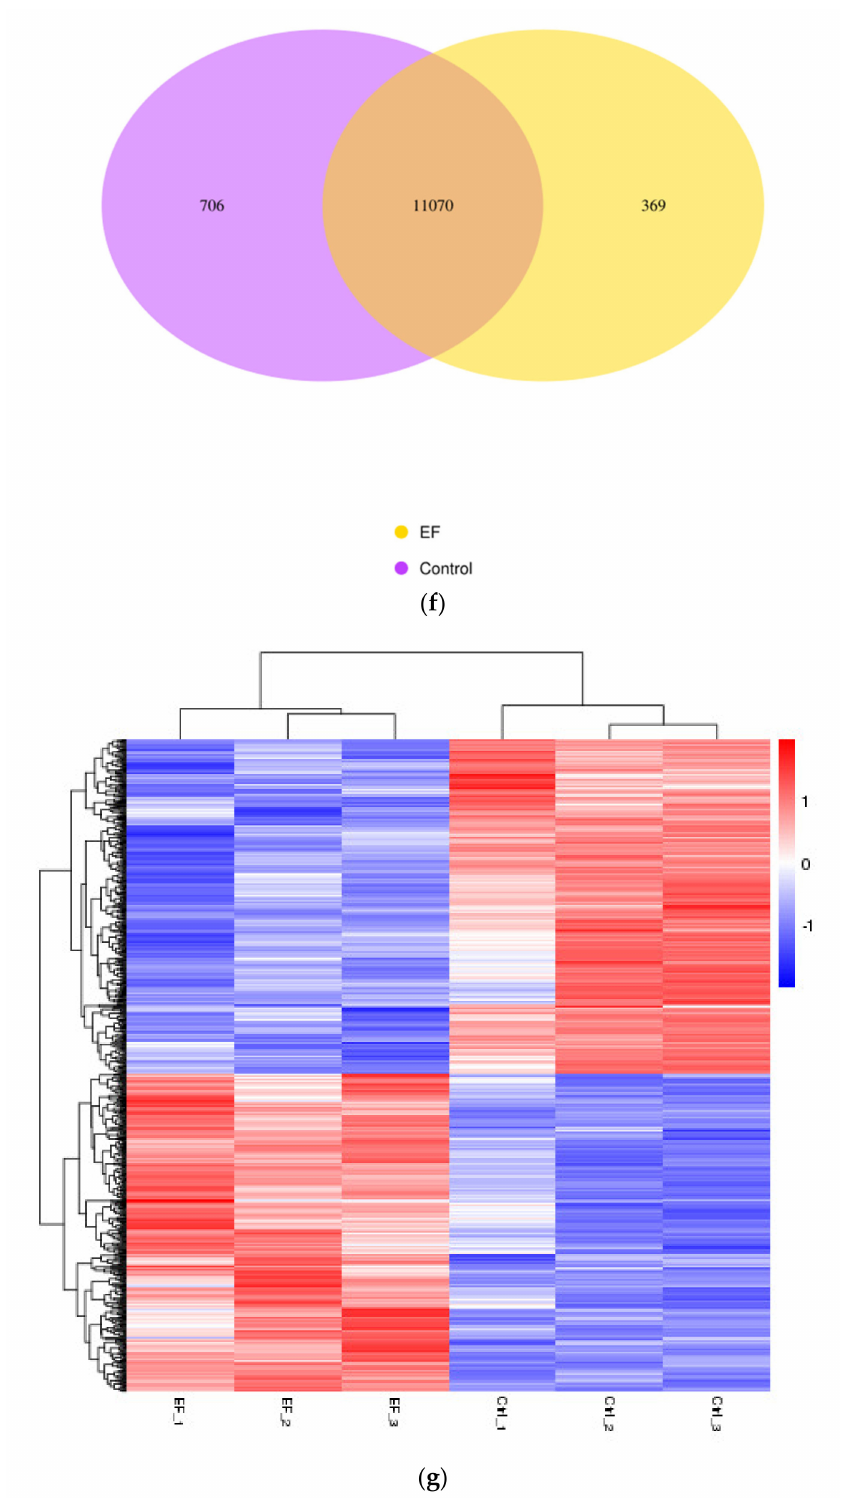
Figure 1. Basic information on RAW 264.7 cells and RNA-Seq. ( a ) The cell morphology of RAW 264.7 cells during the direct current electric field (dcEF) 200 mV / mm treatment. Scale bar, 100 µ m. ( b ) The boxplot of gene expression distribution. ( c ) Violin plot. ( d ) The proportion of the sequenced genes. ( e ) Volcano plot showing metabolomic data (up-regulated genes were represented as red dots and down-regulated genes were indicated as green dots). ( f ) Venn diagram showed the number of overlap genes during the di ff erent groups. ( g ) Heat map of the di ff erentially expressed